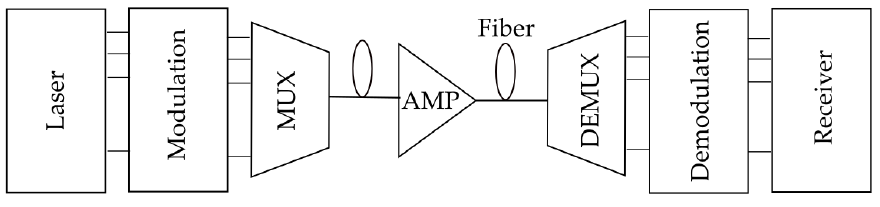
Figure 1. Optical network scheme.